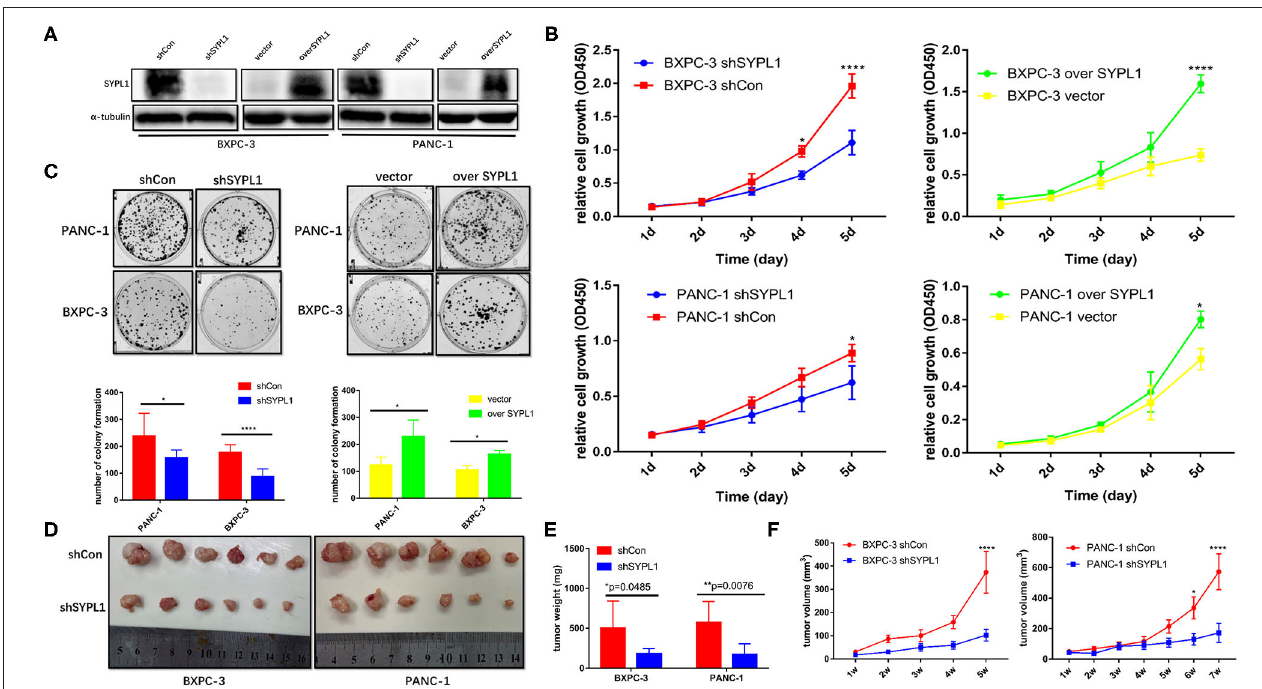
FIGURE 4 | SYPL1 promoted cell proliferation. (A) Western blotting showed knockdown and overexpression of SYPL1 in BXPC-3 and PANC-1 cells. (B) CCK8 assay showed that knockdown of SYPL1 suppressed cell proliferation and vice versa. (C) Colony formation assay showed that knockdown of SYPL1 significantly reduced the colony formation ability and vice versa. (D) Suppression of SYPL1 significantly inhibited tumor growth as determined by a subcutaneous xenograft mouse model. (E) Tumor weight of the indicated cells after nude mice were sacrificed. (F) Curves of tumor diameter after the indicated cells were implanted in the subcutaneous xenograft mouse model. * p < 0.05, ** p < 0.01 and **** p <